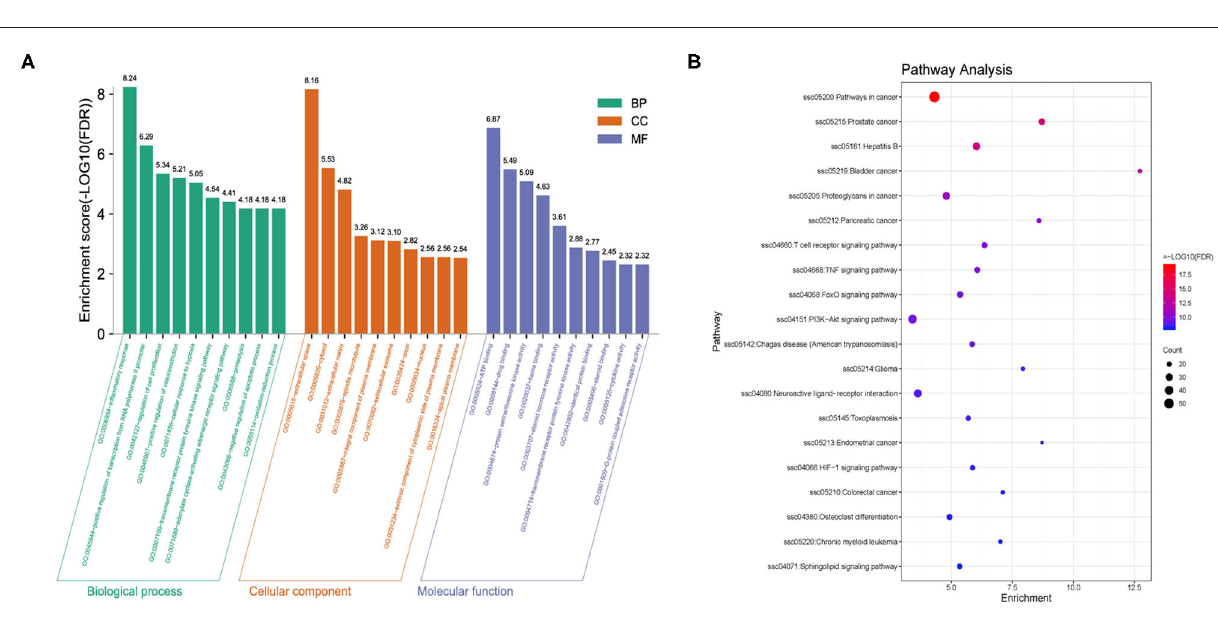
= 86, HQ15), baicalein (degree = 83, CQC2), stigmasterol (degree = 76, M), isorhamnetin (degree = 72, HQ5), dinatin (degree = 71, CQC1), jaranol (degree = 62, HQ2), 6-OH-luteolin